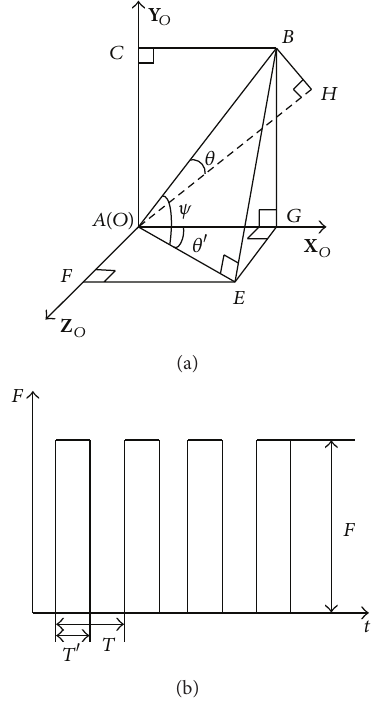
Figure 6: The librations (a) and the thrust force